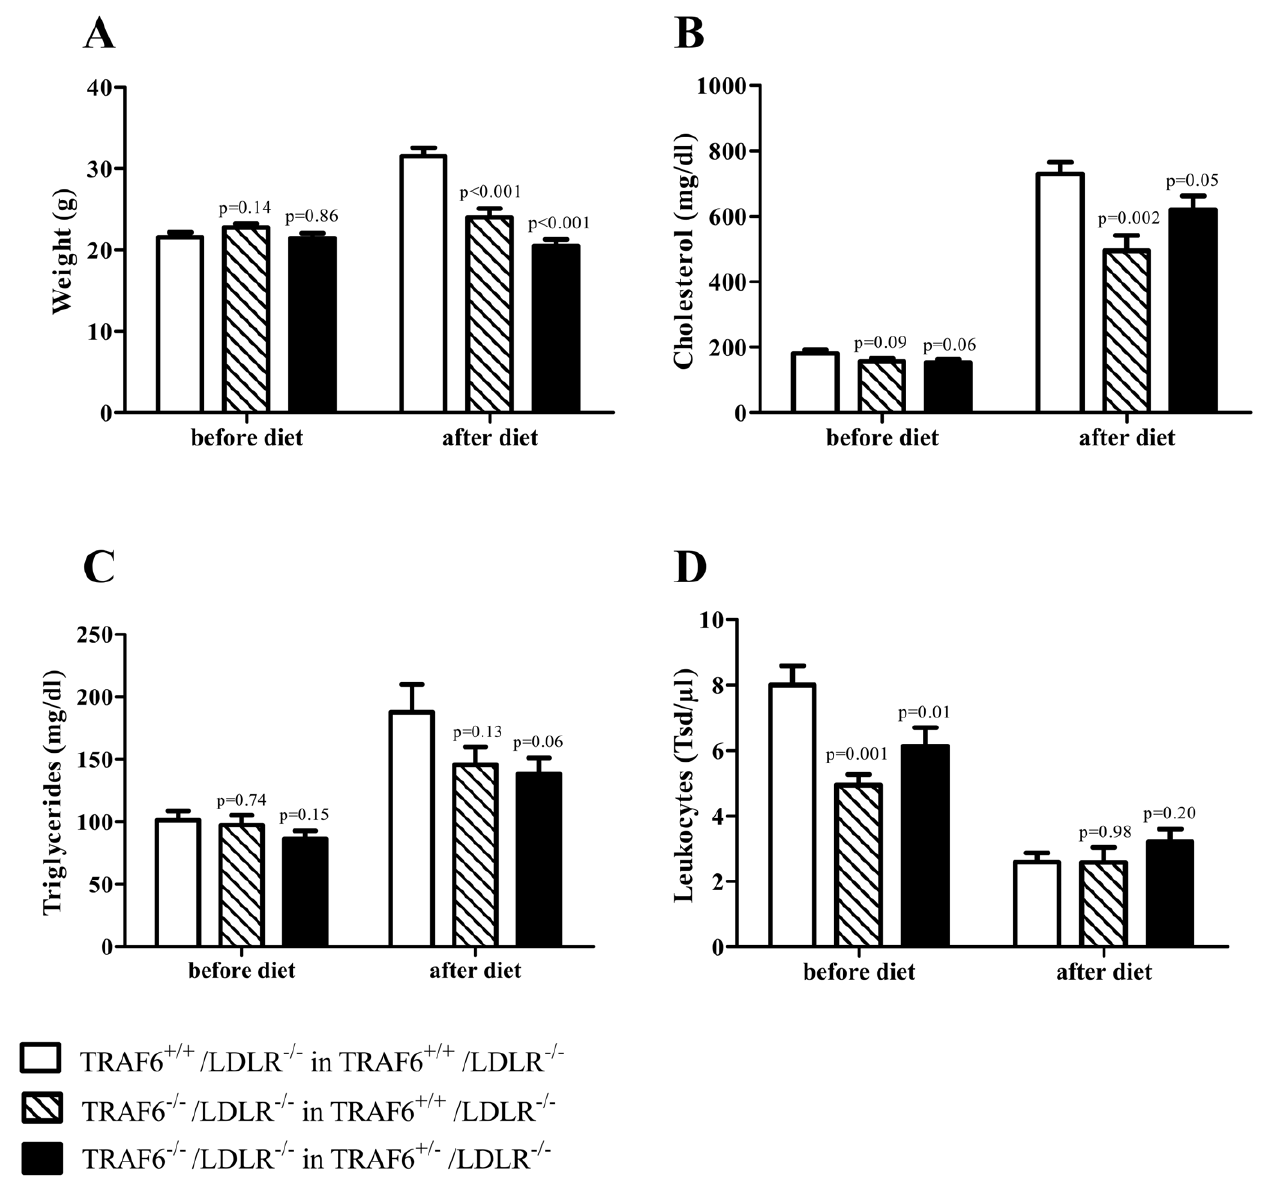
Figure 3. Weights, cholesterol-, and leukocyte levels before and after high cholesterol diet. Lethally irradiated 6 week old TRAF6 + / + / LDLR 2 / 2 mice received TRAF6-deficient (hatched bars, N=22) or competent fetal liver cells (white bars, N=27), TRAF6 + / 2 /LDLR 2 / 2 mice received TRAF6-deficient fetal liver cells (black bar, N=23) only. Subsequently, all groups consumed high cholesterol diet (HCD) for 18 weeks. Weights (A), plasma cholesterol levels (B), triglycerides (C), and leukocyte counts (D) were taken before and after